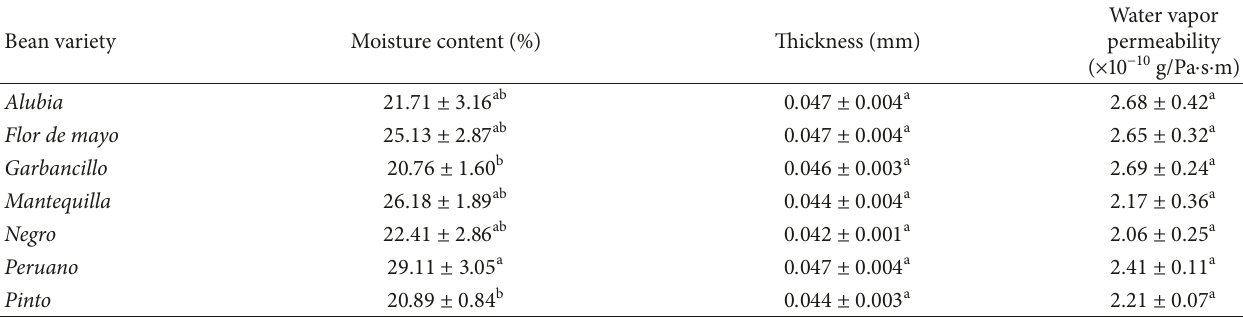
Table 1: Properties of the tested proteinaceous edible films obtained from the studied bean varieties a . Bean